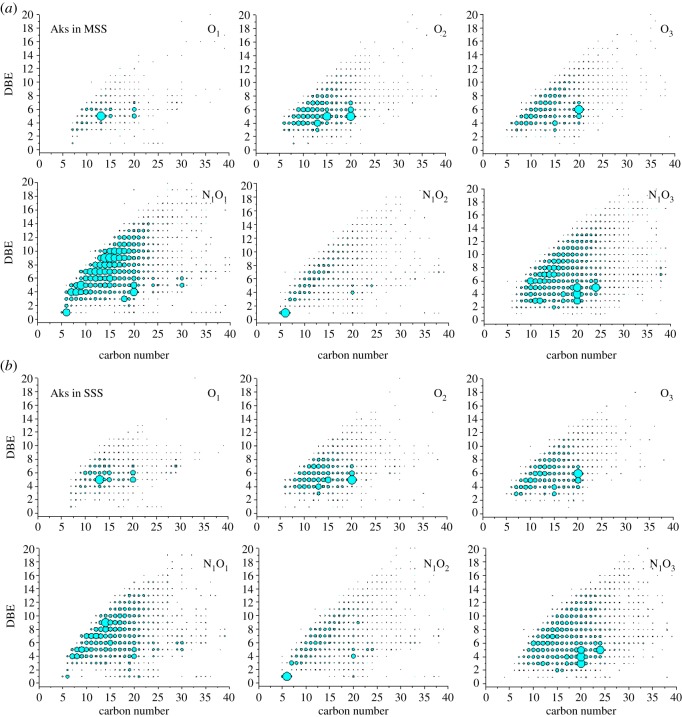
(a,b) Ion relative abundance plots of DBE versus carbon number for O1–3 and N1O1–3 class species.